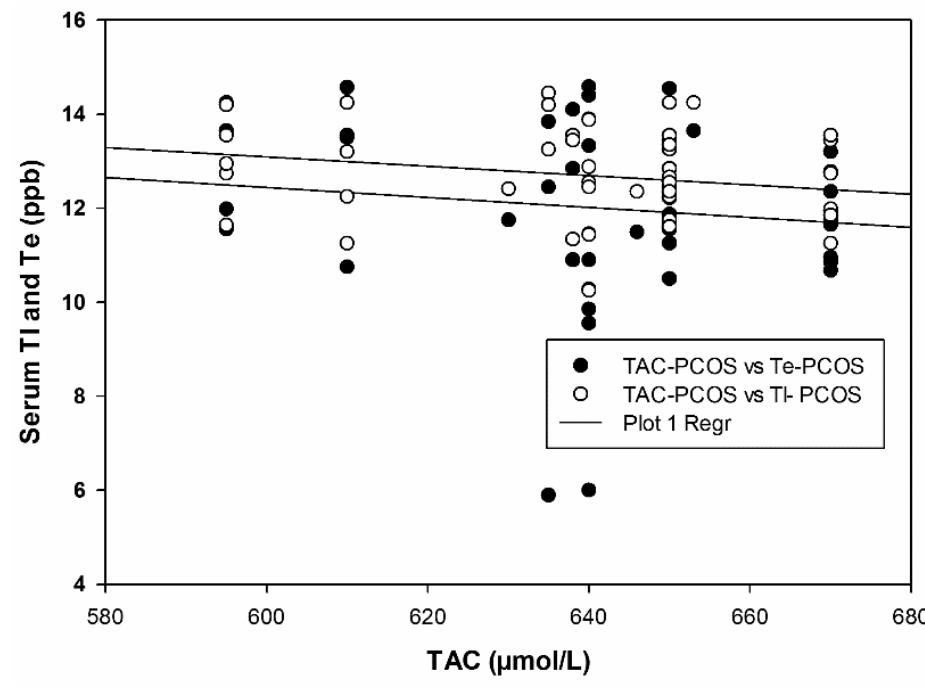
Figure 1. Multiple regression plot of TI and Te with TAC in PCOS.